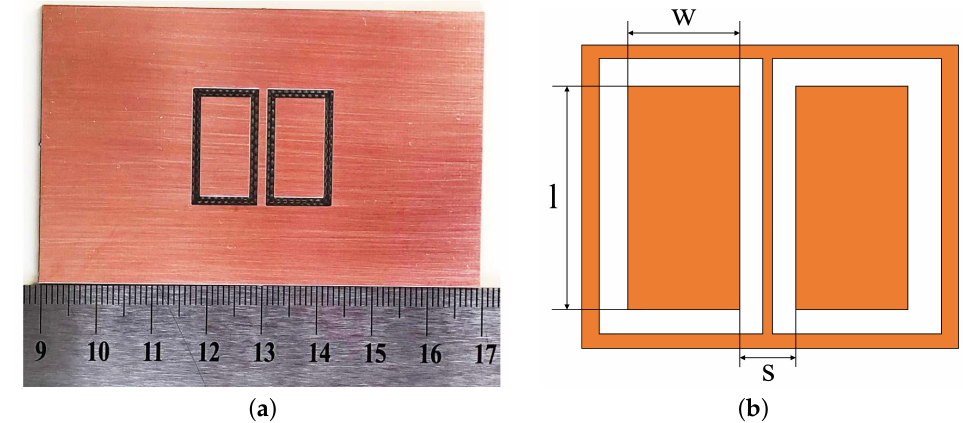
Figure 1. ( a ) Photograph of the rectangular coplanar capacitive probe used in this paper and ( b ) schematic diagram of a rectangular probe. l , w and s represent the length, width and separation distance,